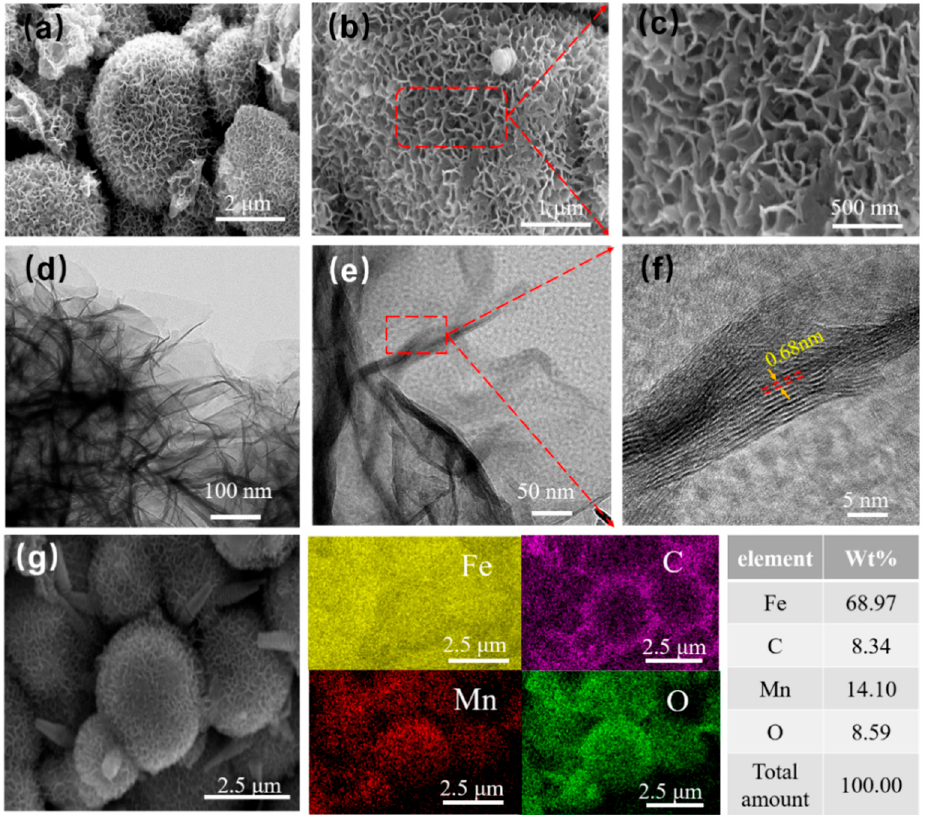
Figure 3. SEM images ( a – c ), TEM images ( d – f ), and element mapping ( g ) of CIP@MnO 2 compo-